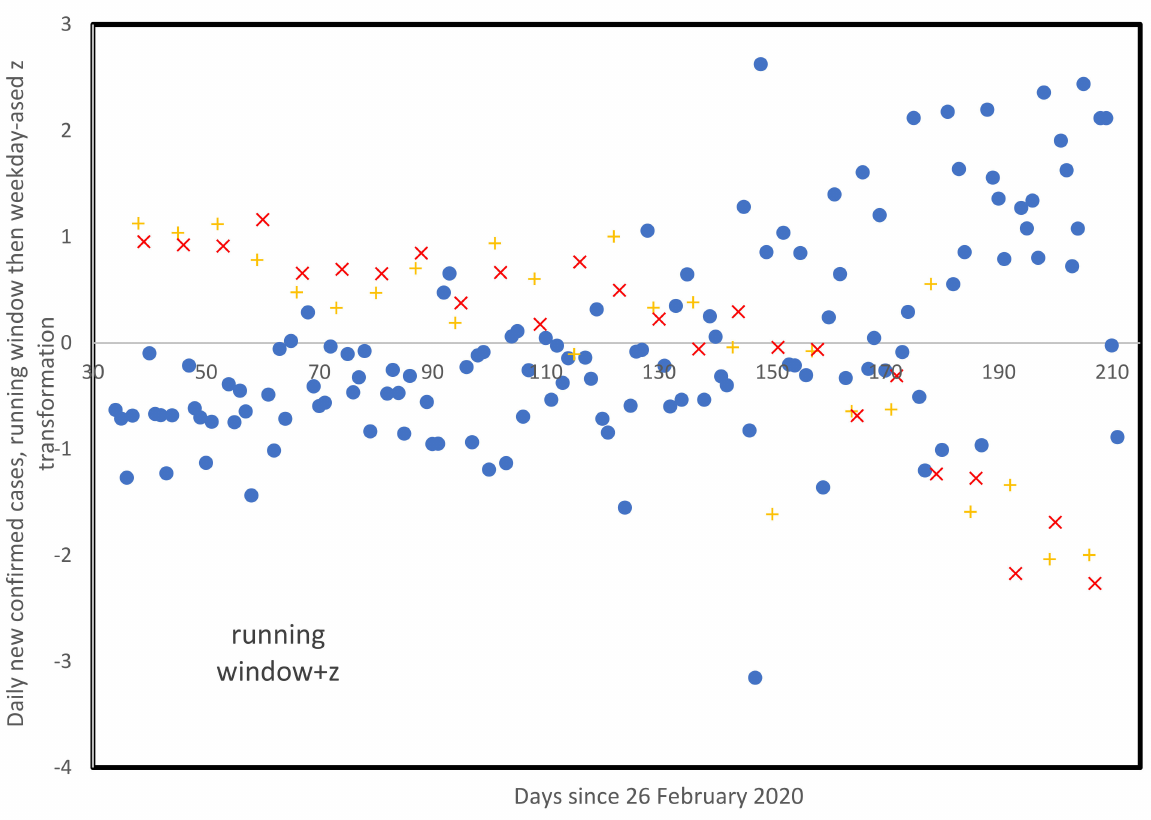
Figure 11. Z-transformed scores of smoothed confirmed world daily new cases [30] smoothed data from Figure 9, as a function of days since 26 February 2020 until 23 August 2020. + indicates Sundays, X indicates Mondays. Z-transformations are specific to each